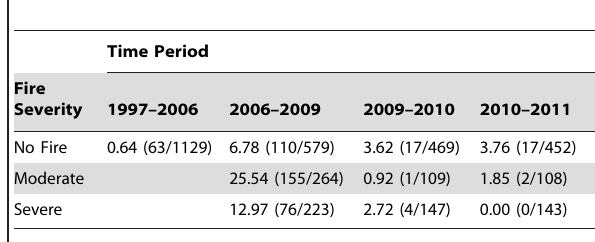
Table 3. Percentage rates of collapse of large cavity trees by fire category adjusted (standardized) for the duration of each period.